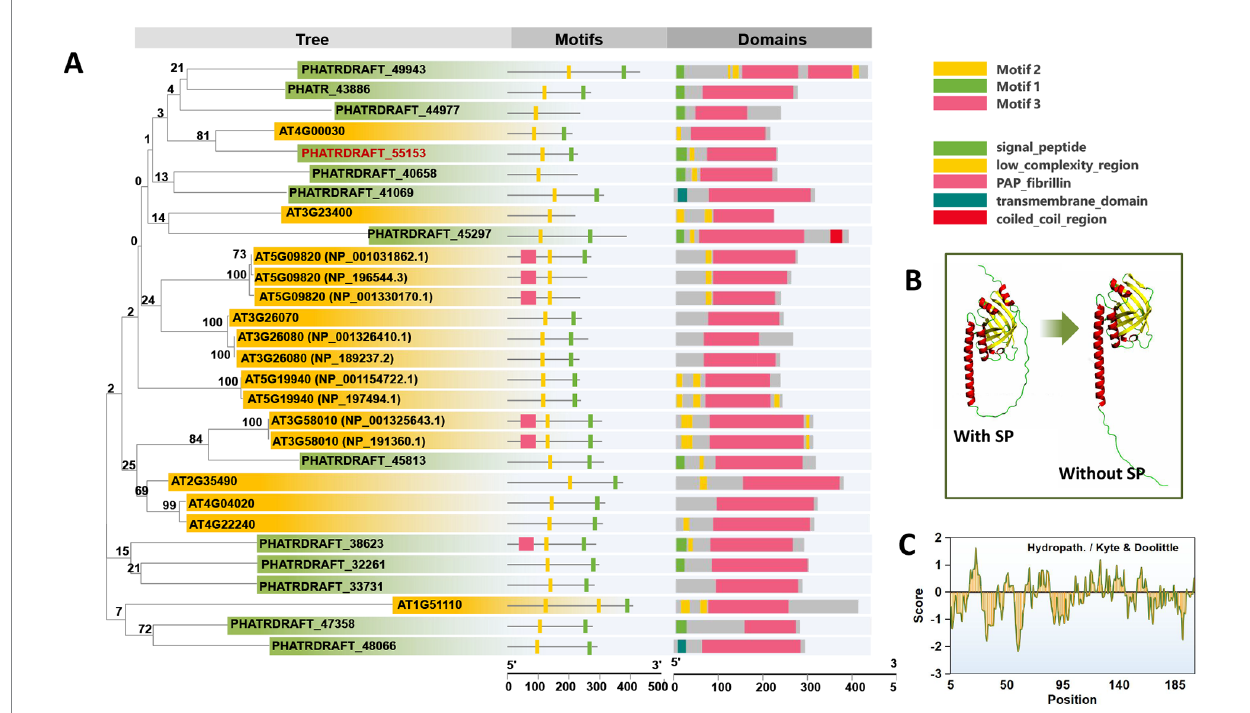
FIGURE 1 Sequence analysis of PAP proteins from P. tricornutum . (A) Phylogenetic tree analysis, motif analysis, and functional domain analysis of PAP/fibrillin proteins in P. tricornutum and A. thaliana . (B,C) Protein structure prediction and hydrophobicity analysis of PHATRDRAFT_55153. SP: signal peptide. All protein sequences are provided in Supplementary Data